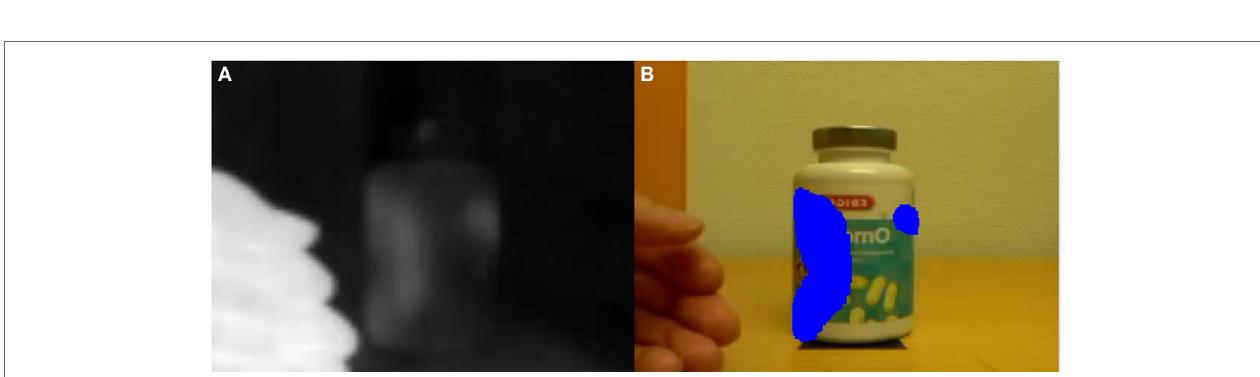
FigUre 4 | An example of inference from single images in a simple case. (a) RGB image, (B) thermal image, (c) objects detected, with a few false positives and negatives, (D) initial mask image from bounding boxes to reduce noise, (e) thermal image with touched region and contour centroid detected, and (F) touched object identified.